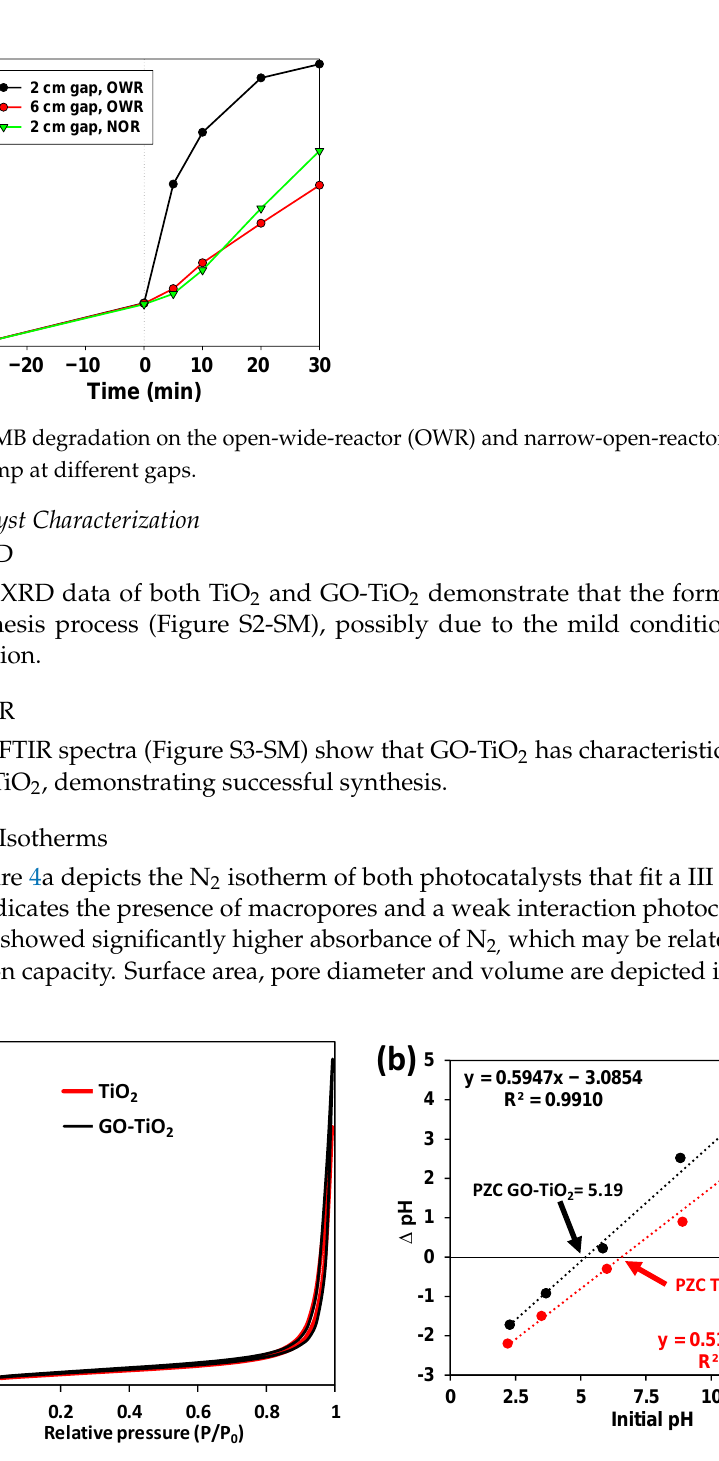
Figure 4. Mechanisms explaining the absorption behavior: ( a ) N 2 isotherm and ( b ) point of zero charge of TiO 2 and GO-TiO 2 .